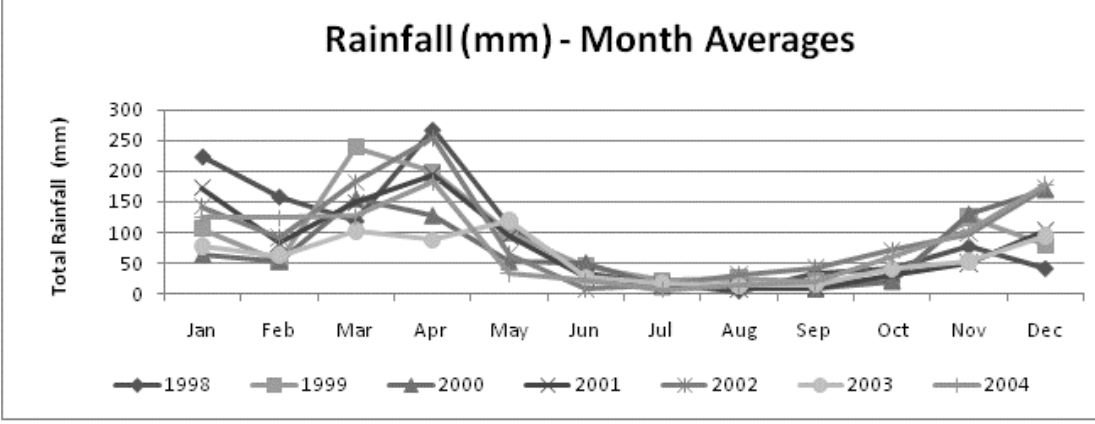
Figure 2. Seasonal distribution of rainfall in Tanzania: Monthly averages